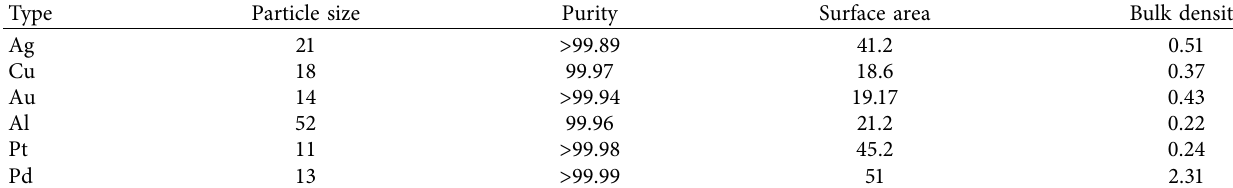
Table 3: The main parameters of